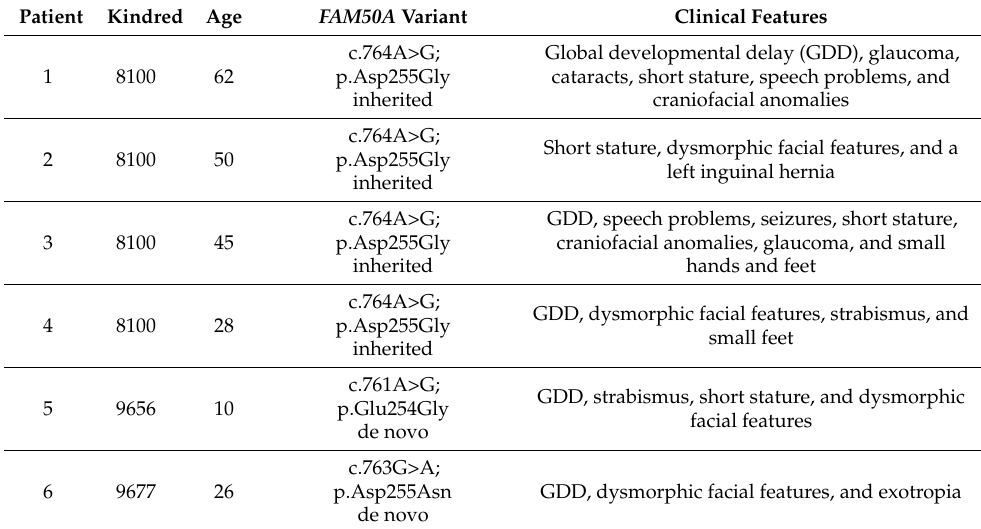
Table 1. Clinical and genetic information of the